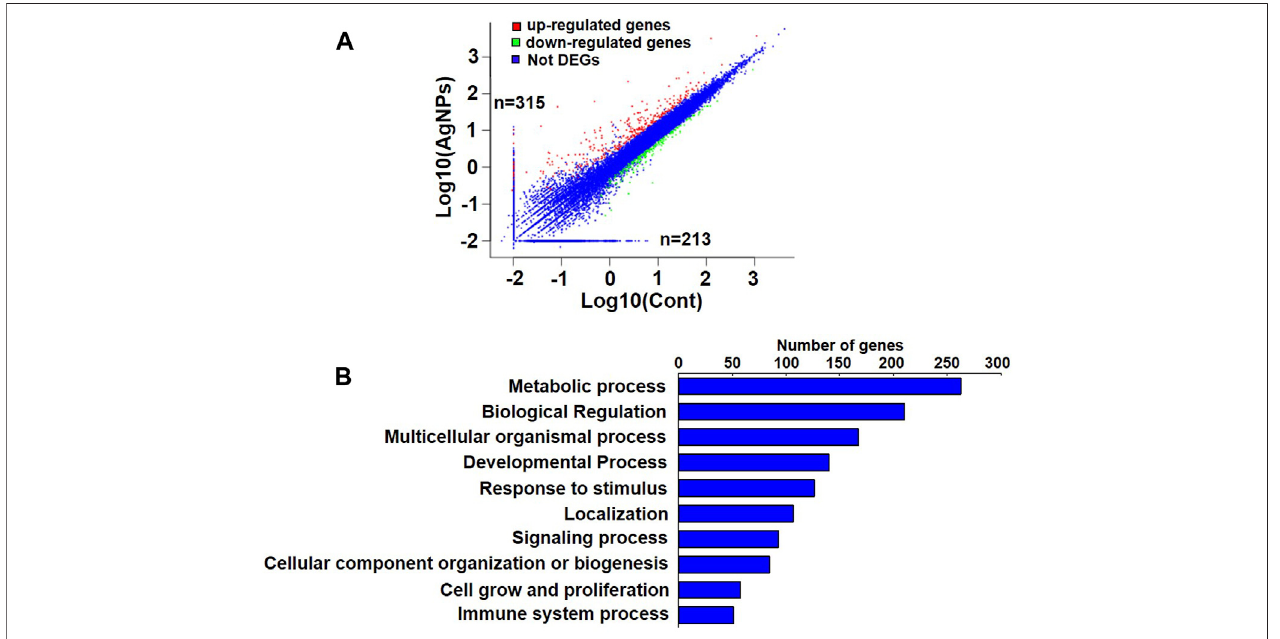
FIGURE 4 | The analysis of gene expression and gene ontology in HEK293T cells exposed to AgNPs. (A) Analysis of upregulated and downregulated genes in HEK293T cells upon 4 μ g/ml AgNPs exposure. (B) Gene ontology and pathway analysis of differential expressed genes in HEK293T cells treated with 4 μ g/ml AgNPs.